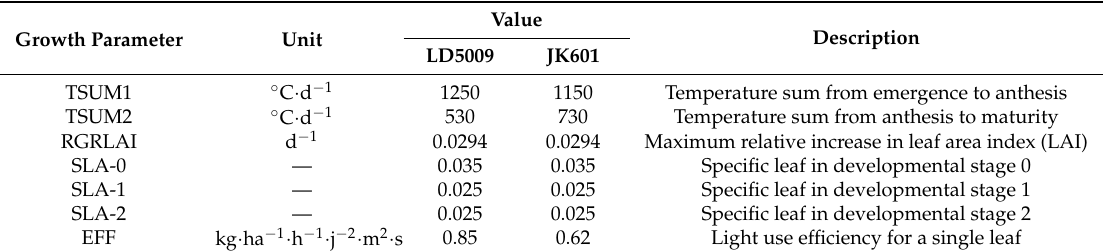
Table 5. Sunflower growth parameters of the WOFOST model under the potential condition.